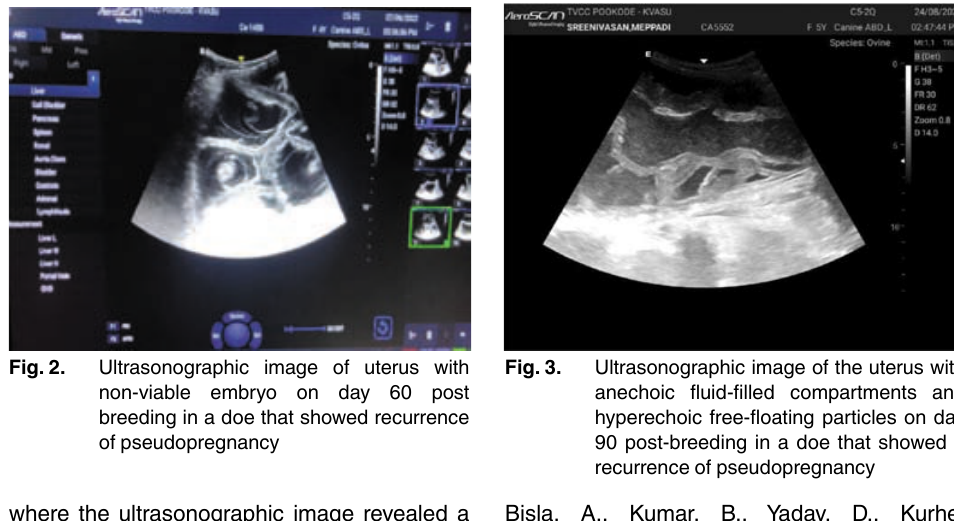
Fig. 3. Ultrasonographic image of the uterus with anechoic fluid-filled compartments and hyperechoic free-floating particles on day 90 post-breeding in a doe that showed a recurrence of pseudopregnancy